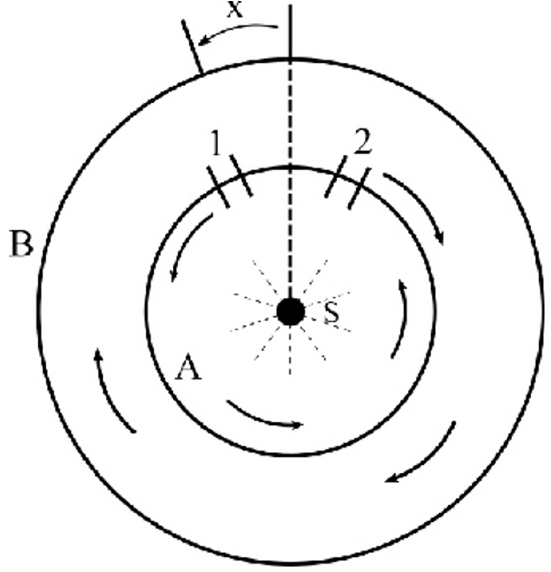
Figure 1. Chichilnisky two rotating hole experiment (top Figure 4: Chichilnisky two rotating hole experiment (top view)